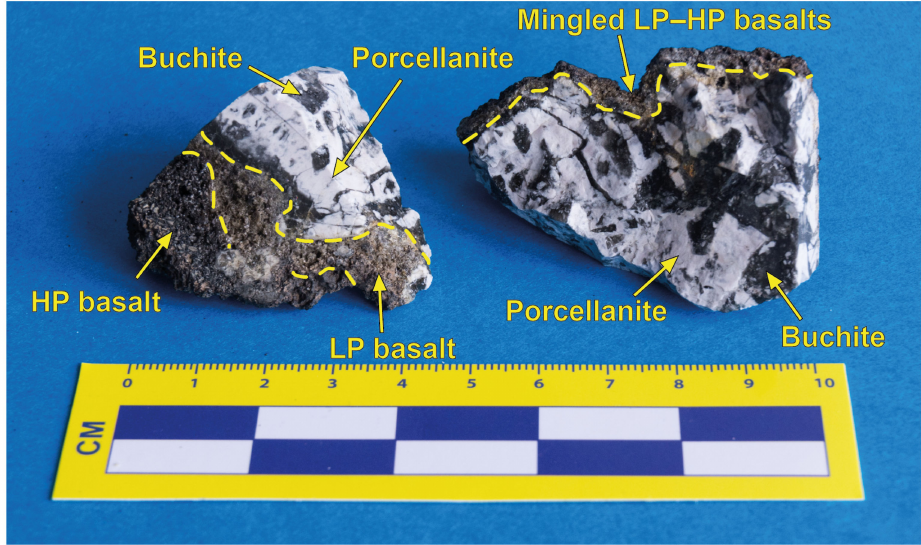
Figure 2. Two fragments of the composite B1 xenolith consisting of white porcellanite and dark buchite. Cuspate–convolute contacts between porcellanite and buchite portions are highlighted, as well as the juvenile basalt coating the sample. Both HP (highly porphyritic, black scoria) and LP (low porphyritic, highly vesicular “golden” pumice) are emphasized, as distinct magmas or mingled with each other. It is worth noting that the LP basalt is only involved during the paroxysmal eruption of Stromboli such as that of the 5 April 2003 when the porcellanite–buchite xenolith